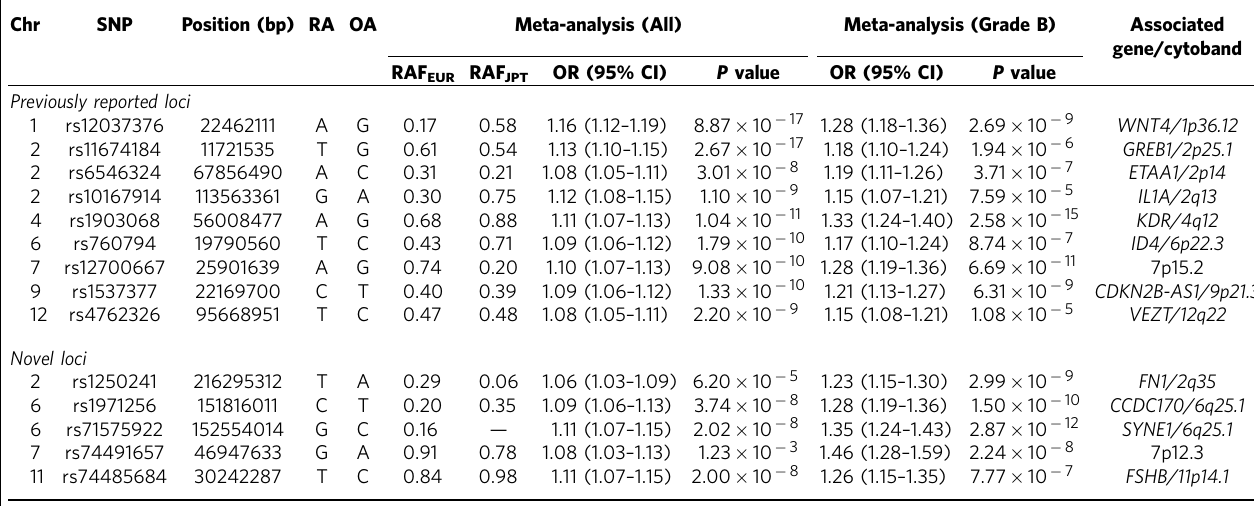
Chr, Chromosome; SNP, single-nucleotide polymorphism; Genomic position is shown relative to GRCh37 (hg19); GWA, genome-wide association; RA, risk allele; OA, other allele; OR, odds ratio with respect to RA; CI, confidence interval; RAF EUR , average risk allele frequency in European samples; RAF JPT , average risk allele frequency in Japanese